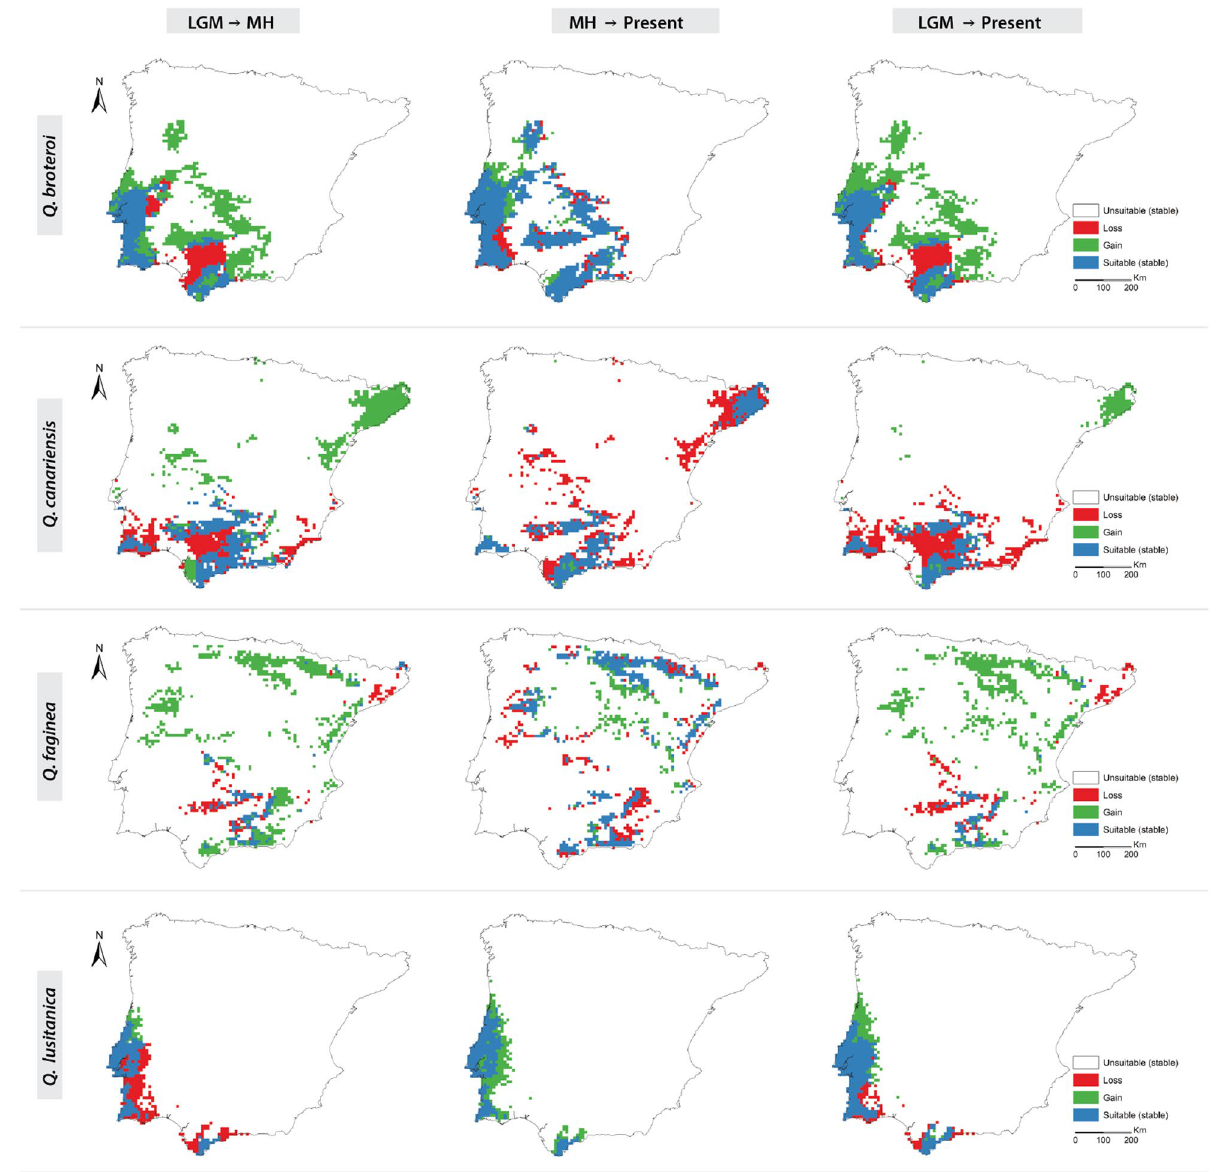
v.4.0.3 (https ://www.r-proje ct.org) and assembled in ArcMap 10.5 (https ://www.esri.com/en-us/arcgi